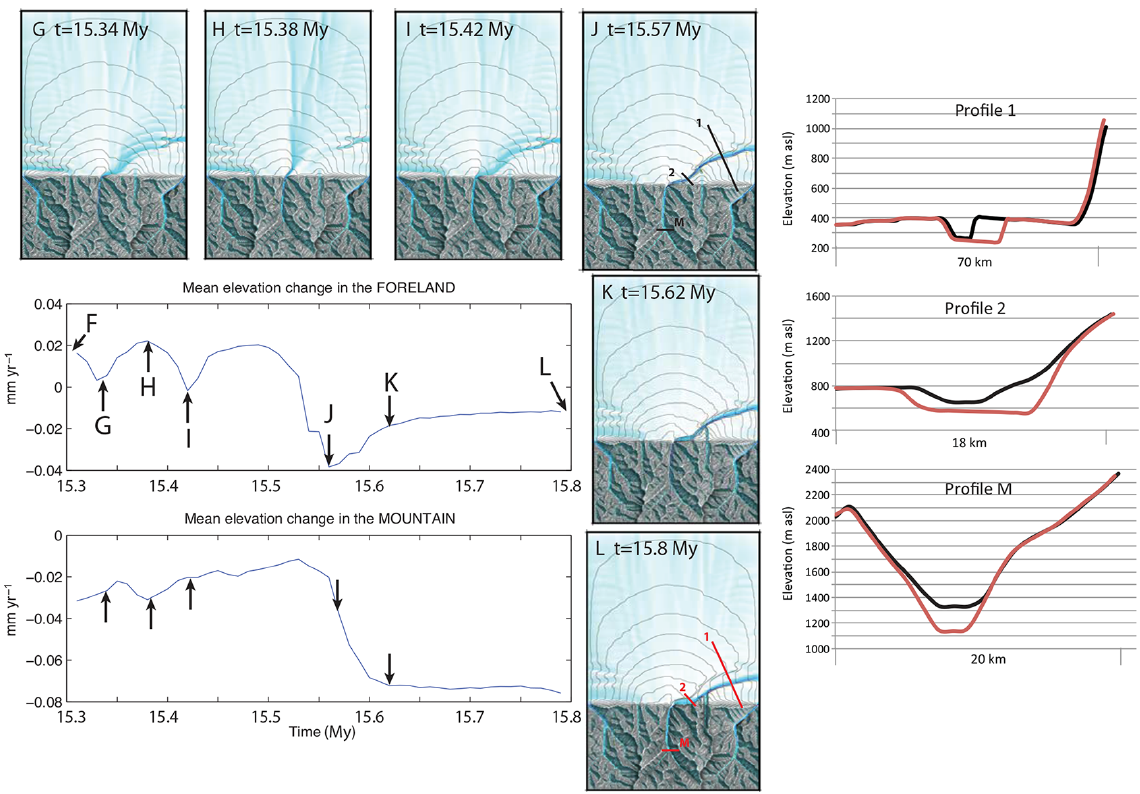
Figure 4. Autogenic entrenchment. Temporal evolution of the mean elevation change in the foreland and mountain and map views of the mountain and foreland landscapes (black lines are 100m contour lines, water flux in blue shades) at the time steps marked with arrows, through the autogenic incision phase (note change in timescale between this figure and Fig. 3). Starting from the landscape obtained at 15.3Myr (see F in Fig. 3), the fan is incised when the main flow reaches the position of a small stream (e.g. G, I) but continues to grow (H) when the main flux overflows and migrates again on the fan. (J) After several of these cycles, the main flow is finally captured permanently in the stream. (K) As the main river now incises laterally towards the mountain front, a secondary stream is captured. (L) At the end of the experiment a large valley is incised along the front of the range. Topographic profiles across this valley (right panel) show that about 120m of incision occurs in the foreland at the time of capture (black profiles, inset J); subsequently the valley is mostly enlarged by lateral erosion in the foreland, deepened and enlarged near the apex, and markedly deepened in the mountain (red profiles, inset L; note that horizontal scale is different for each